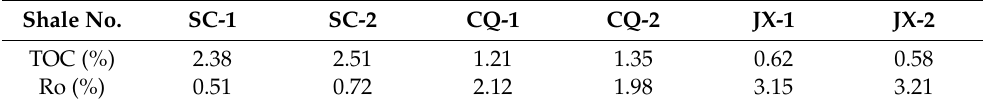
Table A2. TOC content and Ro of the shale samples. Shale